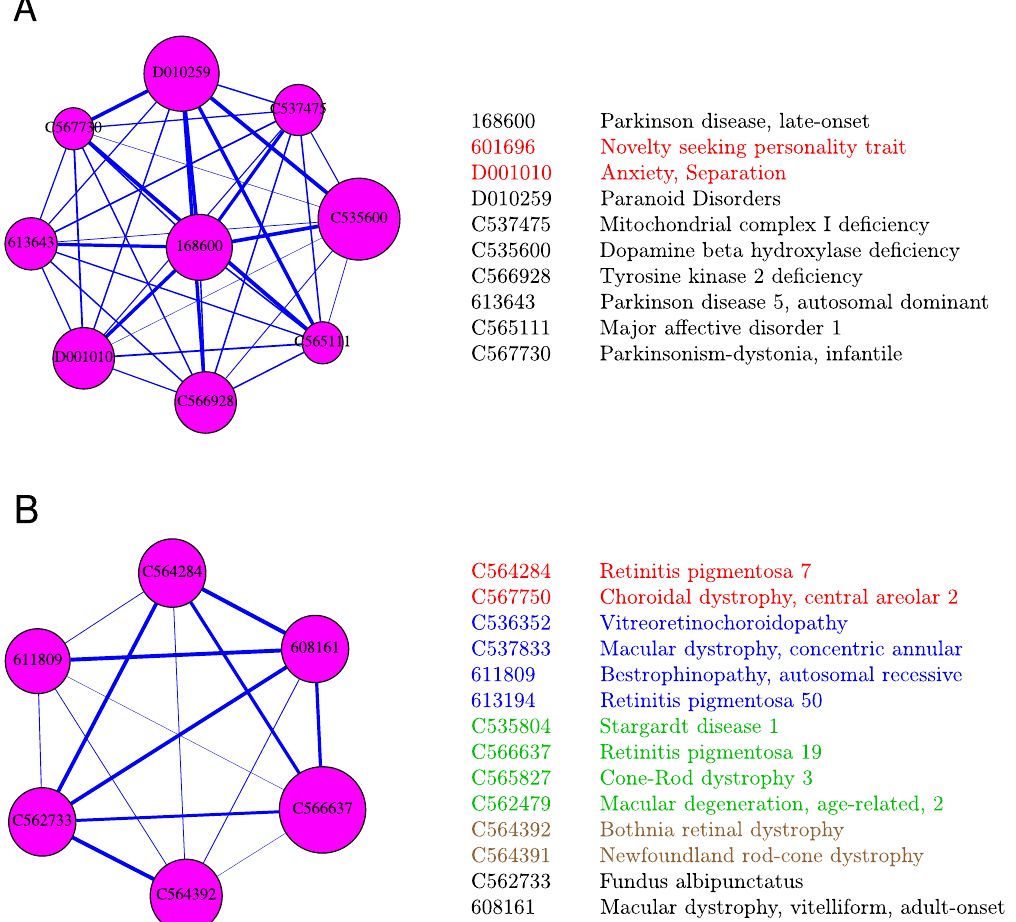
Figure 5. Two example clusters. The clusters that include Parkinson’s disease (OMIM:168600) and Retinitis pigmentosa 7 (MESH:C564284) are shown in panels (A) and (B) respectively. In each case, only diseases with membership probabilities larger than 5% are shown. The size of each node (circle) is proportional to the probability of membership of that node in the cluster. For a disease pair, the thickness of the line linking the diseases is , where C is the correlation between the two diseases and C m is the minimum correlation between all diseases shown in proportional to 1 z log 10 C C m each cluster. The names and IDs of the members of each cluster are also given. Diseases whose names are written in the same color (other than black) have exactly the same gene associations and so are equivalent in our study. Equivalent diseases are represented by one node in the figure. For example, the node identified by C566637 in panel (B) represents the four diseases whose names are in green, i.e. C535804, C566637, C565827, and C562479.